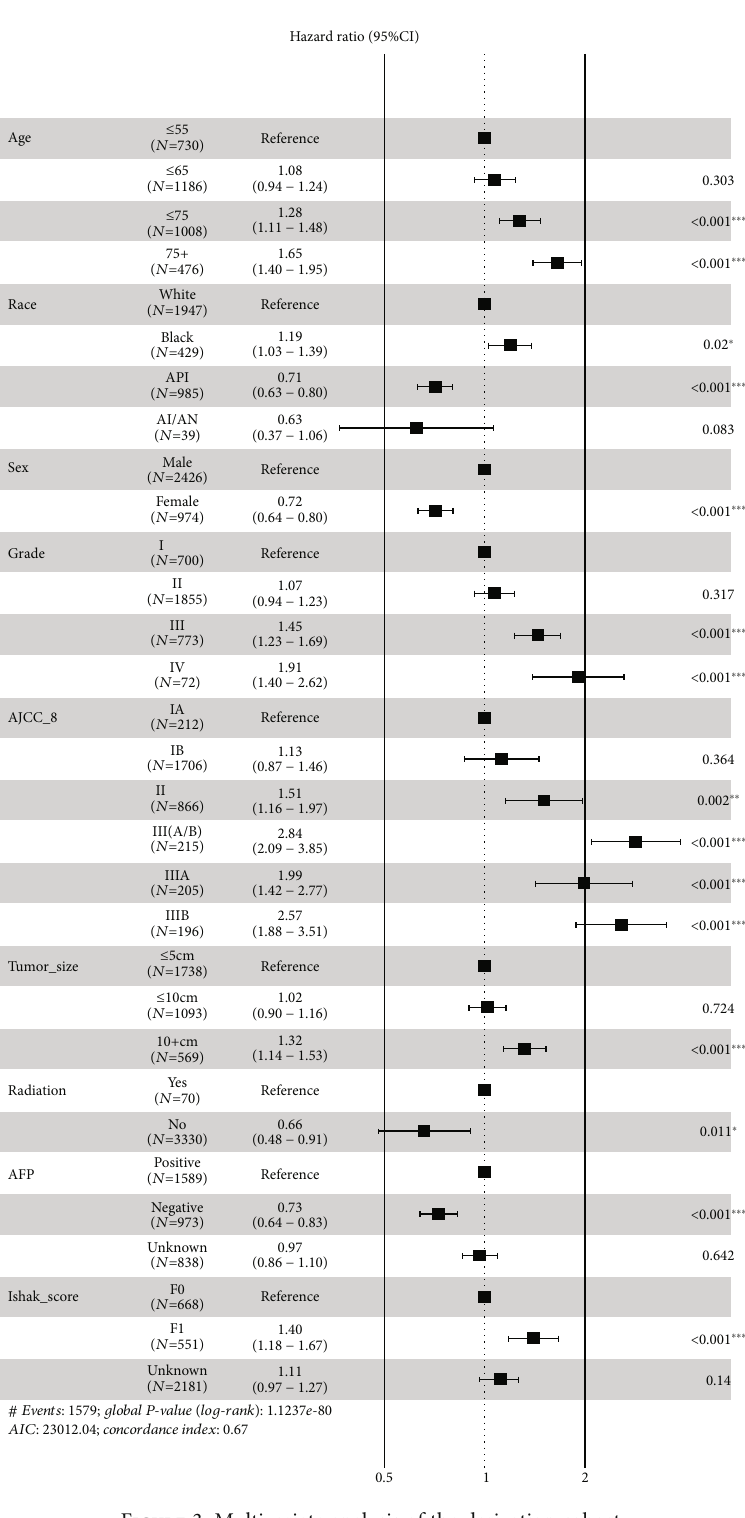
Figure 3: Multivariate analysis of the derivation